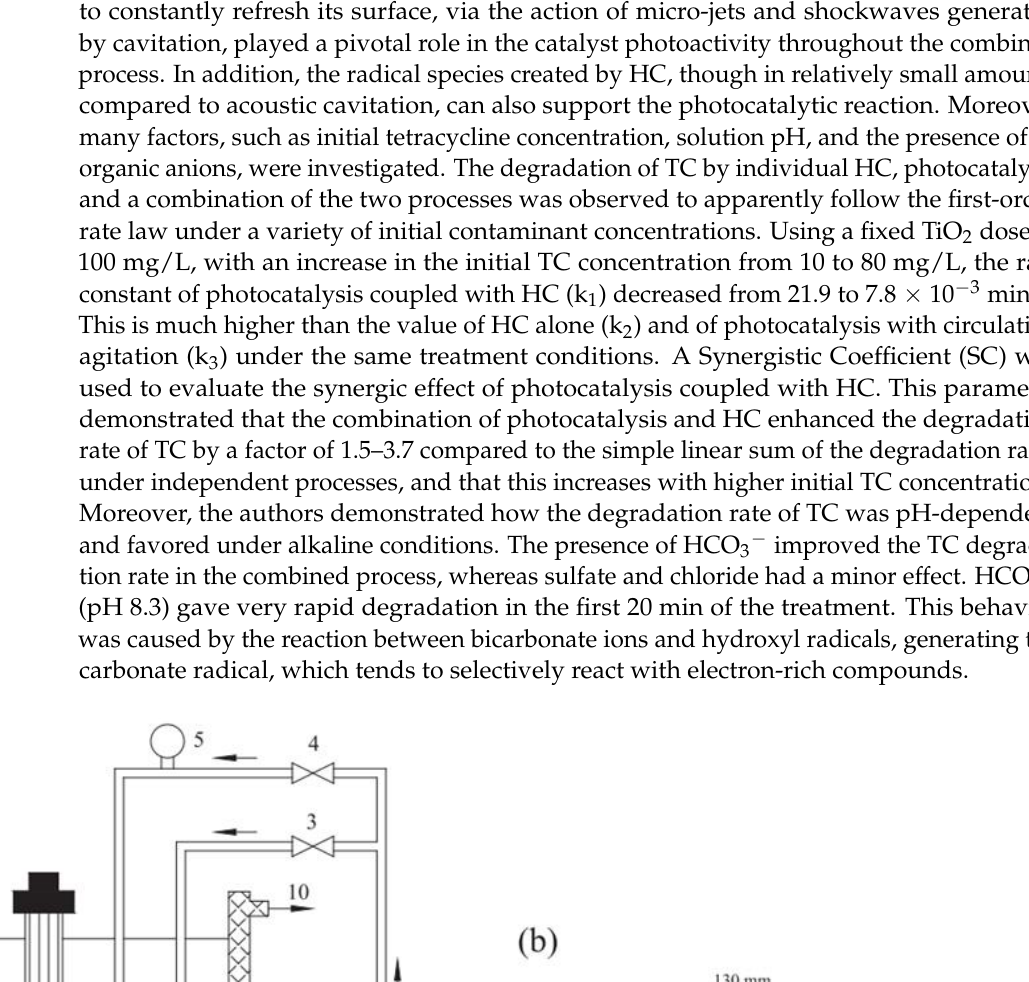
Figure 10. Degradation of 30 mg/L tetracycline in a 4.0 L solution following 90 min of (N) hydro- dynamic cavitation alone, (d) photocatalysis under circulation agitation, 100 mg/L TiO 2 , and (j) simultaneous photocatalysis and hydrodynamic cavitation, 100 mg/L TiO 2 . h is the simple linear sum of N and d (initial pH was natural 4.2; no matrix component was added). Reprinted with per- mission from [46]. 3.2. Sonophotocatalysis with rGO/CdWO 4 Photocatalysts commonly play an imperative role in sonophotocatalytic processes. To date, various photocatalysts have been reported for the decomposition of organic pol- lutants in aqueous matrices, but the lack of efficient photoactivity under solar-light, the high recombination rate of photo-induced electron-hole (e CB− -h VB+ ) pairs, and low re- sistance to photo-corrosion has limited their practicality in environmental applications. Due to their relatively narrow band gap and excellent photocatalytic activity under solar-